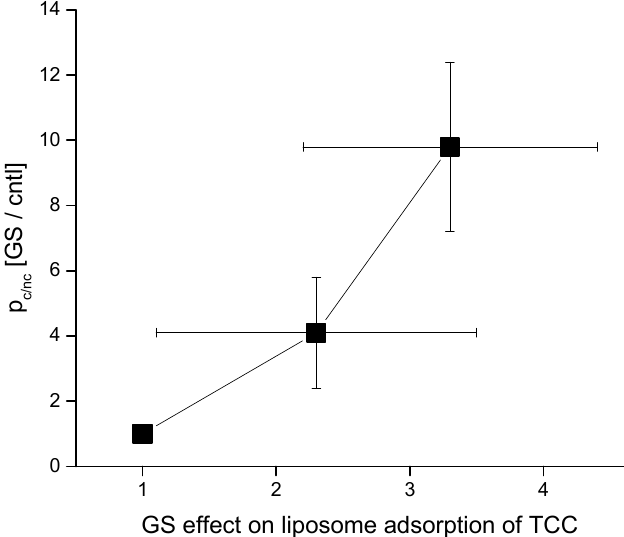
Figure 10. Correlation between GS effects in two different studies—GS effects on CD-induced membrane conductance versus liposome adsorption. Here, I have plotted the data for TCC only as we did not perform any electrophysiology record of membrane currents due to Col effects. Three data points represent the effects of [GS] = 0, 100, 200 nM